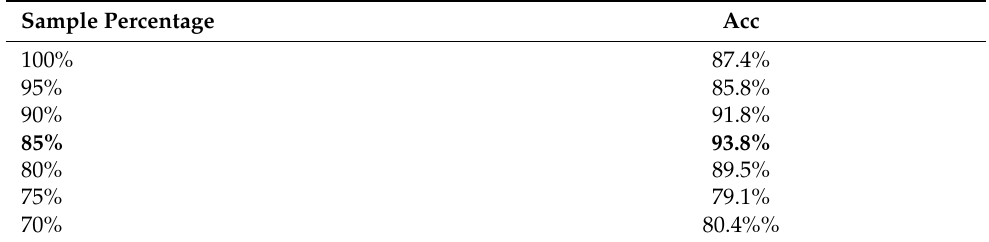
Table 5. Impact of sampling point.